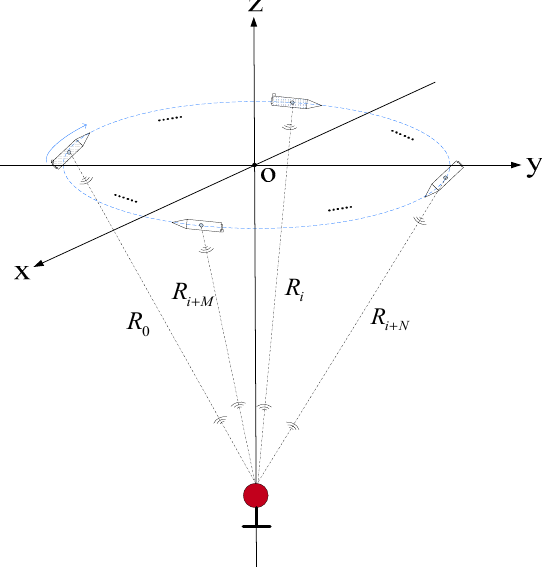
Figure 10. The sailing schematic diagram of the mother ship in the traditional model based on slant range and azimuth method.